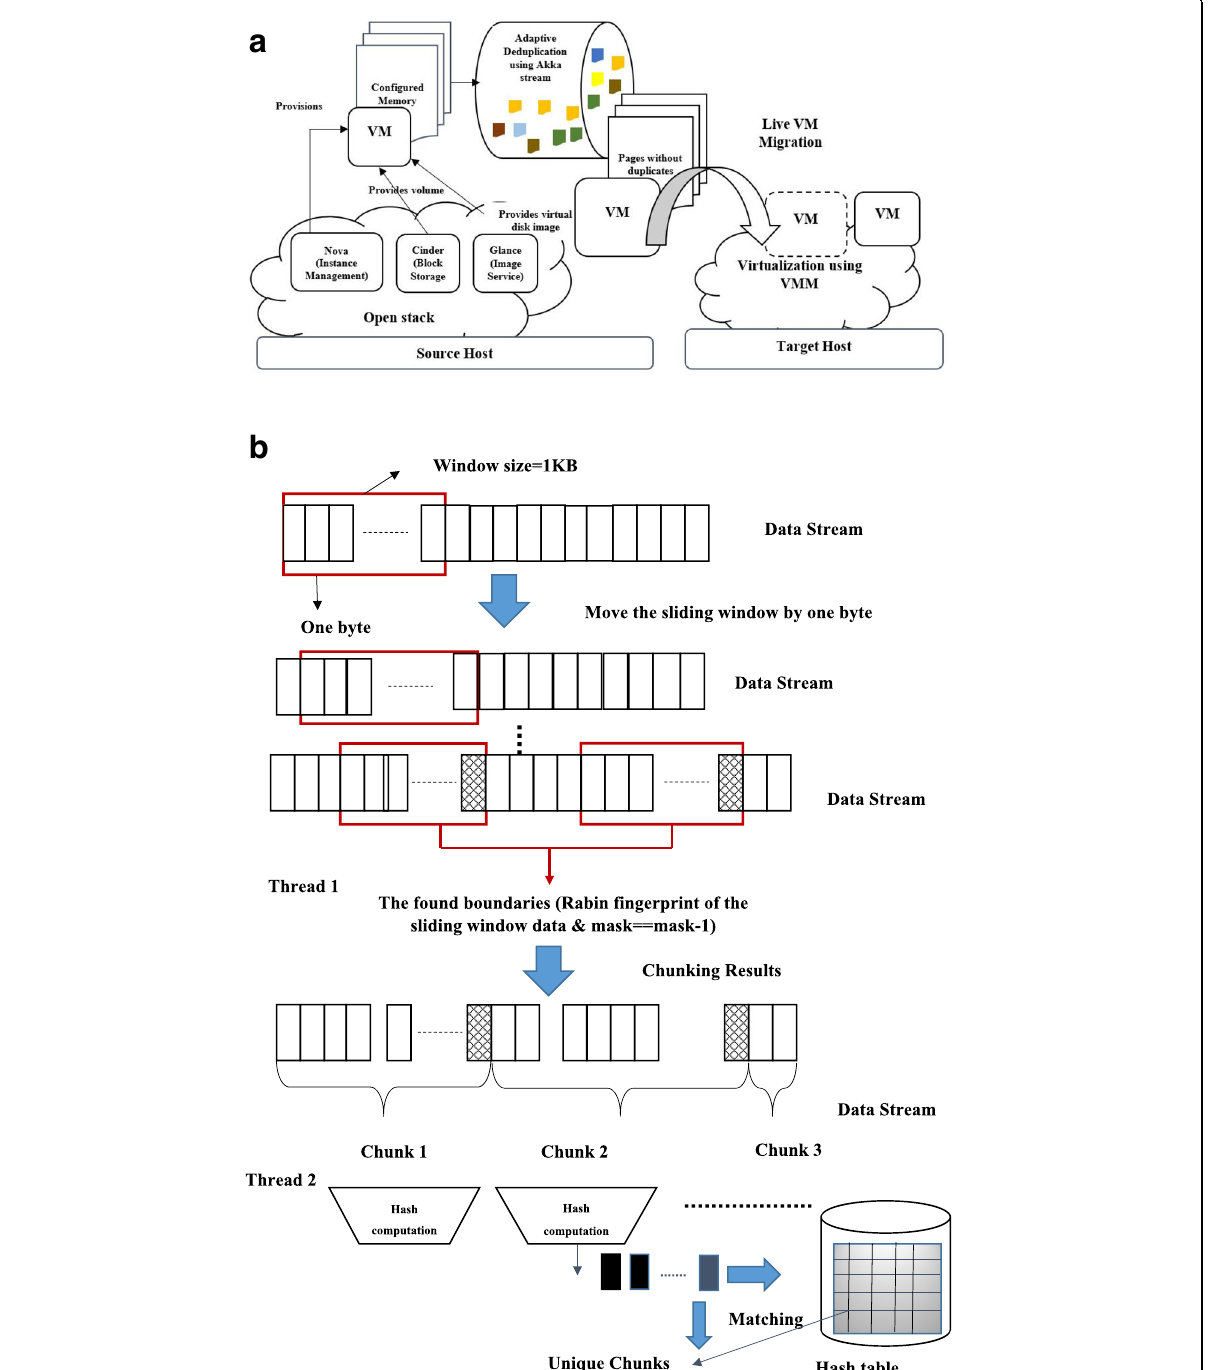
Fig. 3 a System Architecture. b Parallelization of Rabin-Karp Rolling hash algorithm using